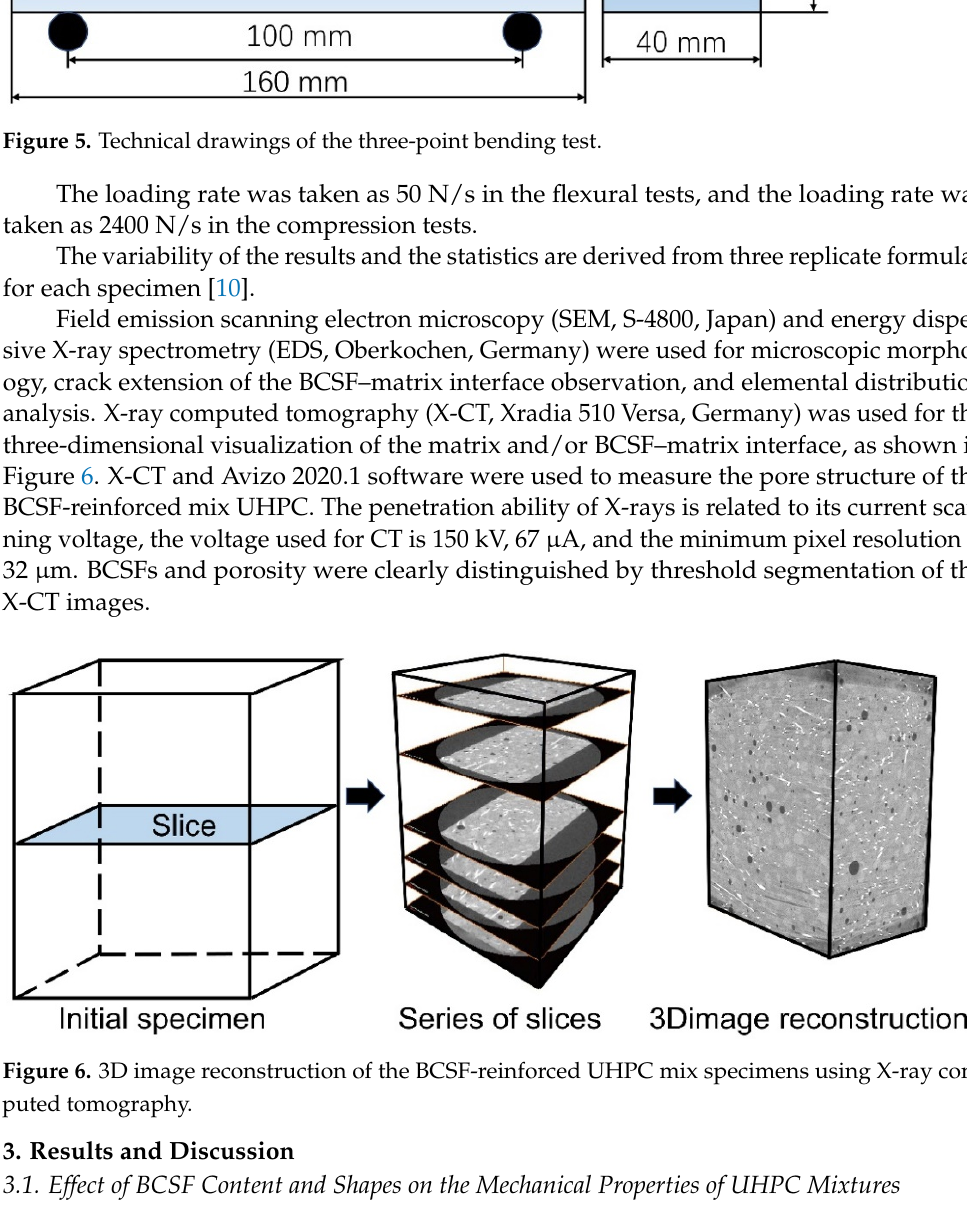
Figure 4. Mechanical properties testing of the BCSF-reinforced UHPC mix specimens: ( a ) flexural strength testing equipment; ( b ) Compressive strength testing equipment.